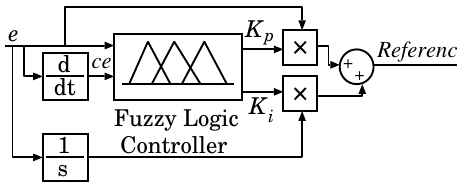
Figure 8. Fuzzy controller based PI control system.